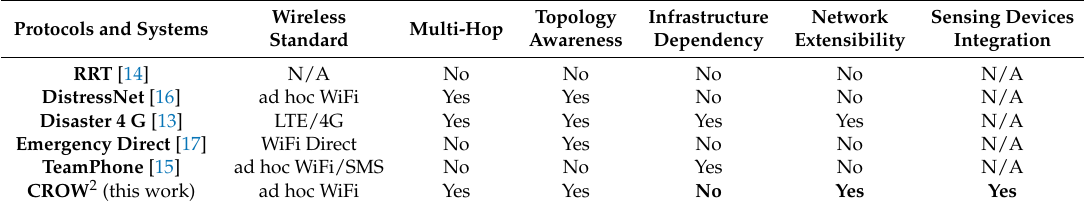
Table 1. Recent implemented disaster management systems benchmark. RRT, Reliable Routing Technique. Protocols and